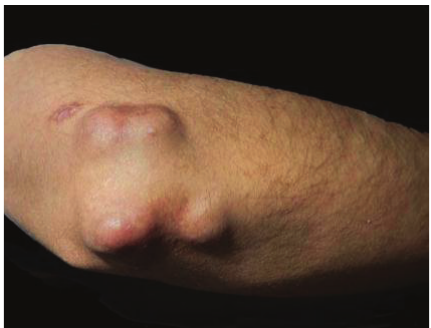
Figure 2: Right elbow with multiple firm nodules with overlying yellow-red papules.